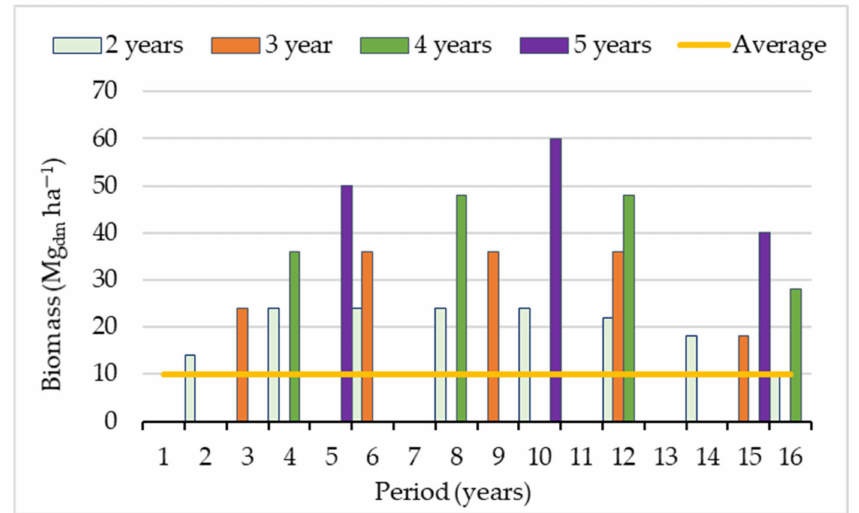
Figure 2. Estimate of dry biomass production in relation to the four cutting cycles